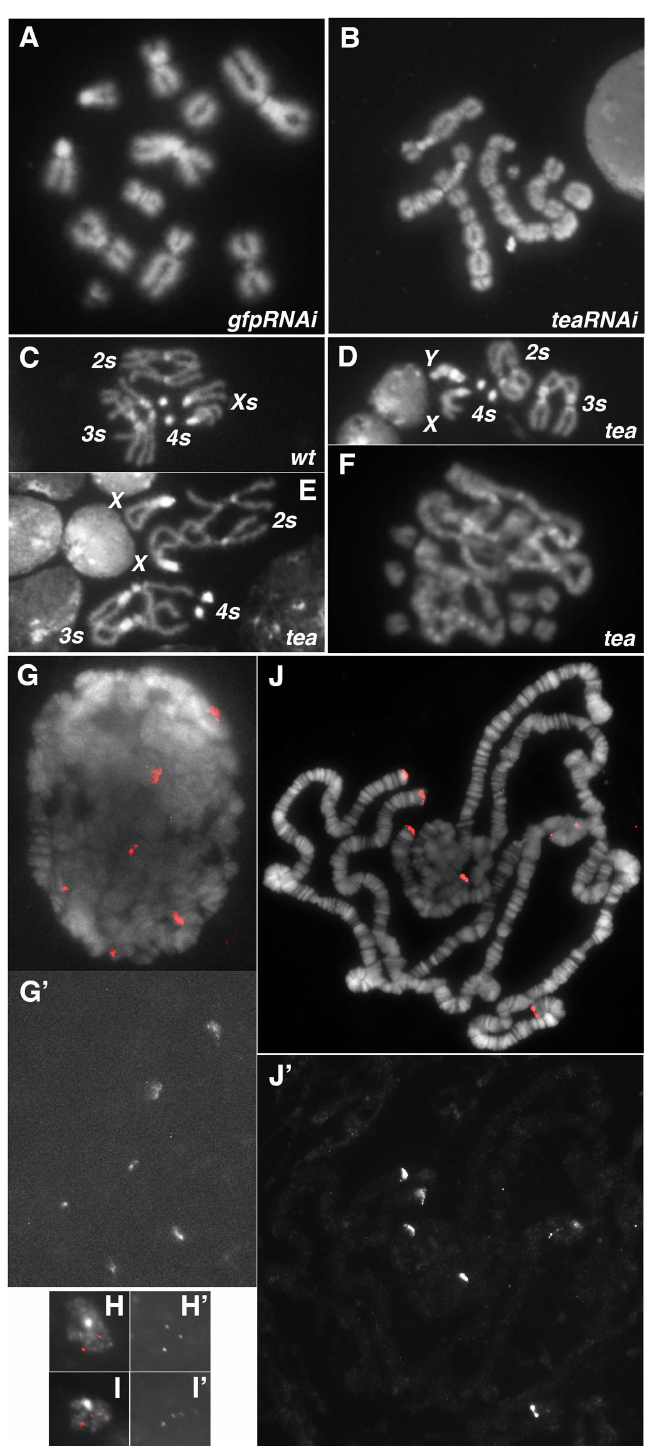
Fig 1. Tea localizes to telomeres for their protection. A, B . Knocking down tea expression leads to telomere fusion in cultured cells. A : a control cell treated with RNAi agents against egfp showingno telomere fusion of mitotic chromosomes. B : a cell treated with RNAi agents against tea showingfusion. C : a female wildtypeneuroblastshowingnormal chromosomes. D-F : mitotic chromosomes from tea mutants showing various degrees of end-to-end fusion. F shows a tea -mutant nucleus with essentially all